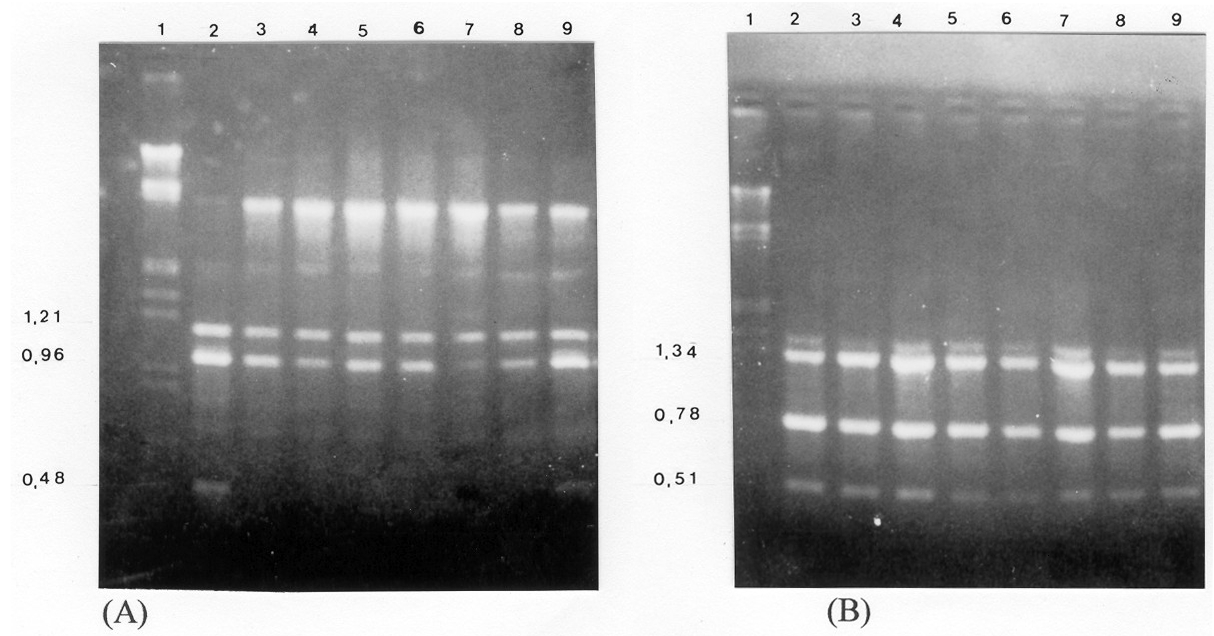
Figure 1 - Gel showing amplification products from Drechslera teres isolates with primers B02 (A) e B07 (B). Lane (1) Lambda DNA digested with Eco RI and Hind III used as molecular weight marker. Lane: (2) isolates Sanad599; (3) Pirat599; (4) Saog599; (5)Vacar599; (6) Palme599; (7) Caraz599; (8) Encru599; (9) Ipira599. Fragment sizes in base pairs are indicated on the